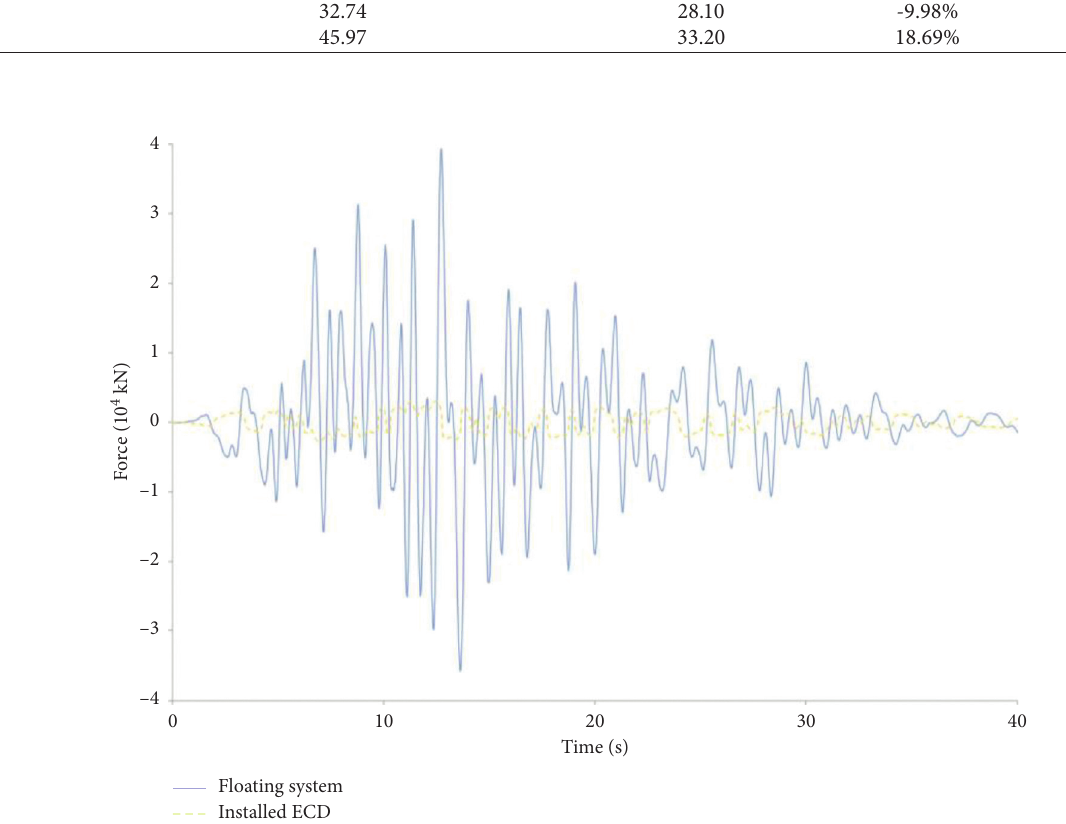
Figure 11: Time history analysis of the ECD tension and the tower base shear.